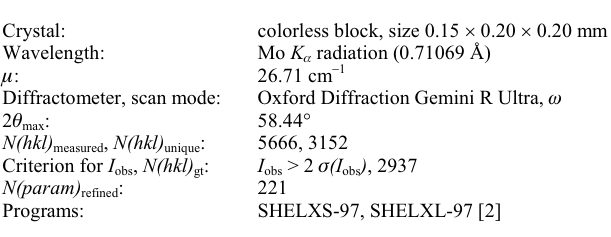
Table 1. Data collection ad handling.